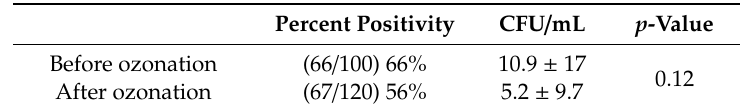
Table 5. Comparison of positivity before and after ozonation in a premise plumbing system. Adapted from Blanc et al. [120].